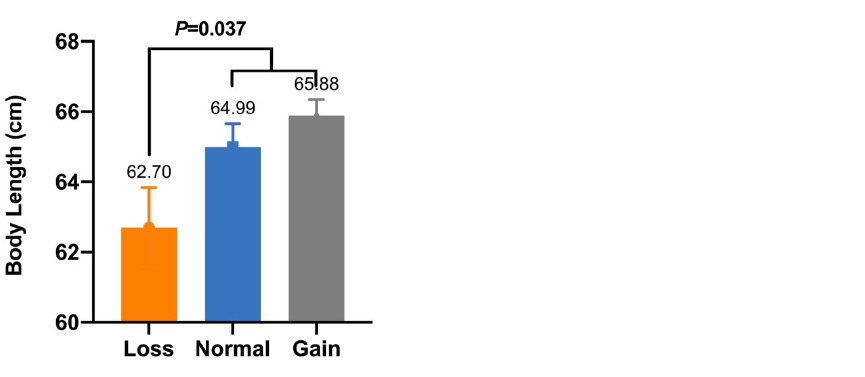
Figure 5. Association analysis between CNV4 and body length in SBWC goats.